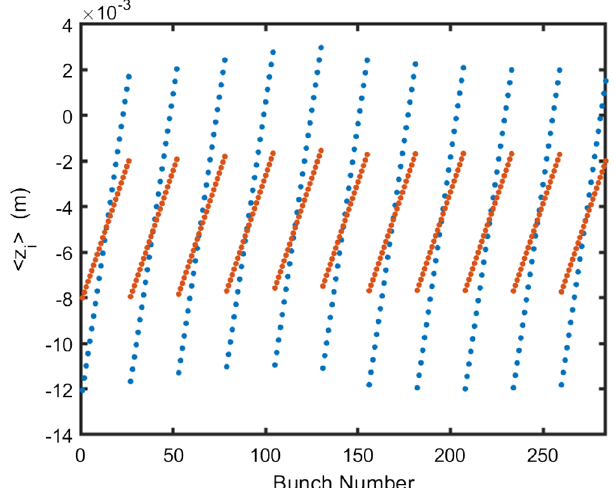
FIG. 5. Charge densities in a train of 26, surrounded by gaps of 4 buckets, fill C2, MC beam loading omitted, I